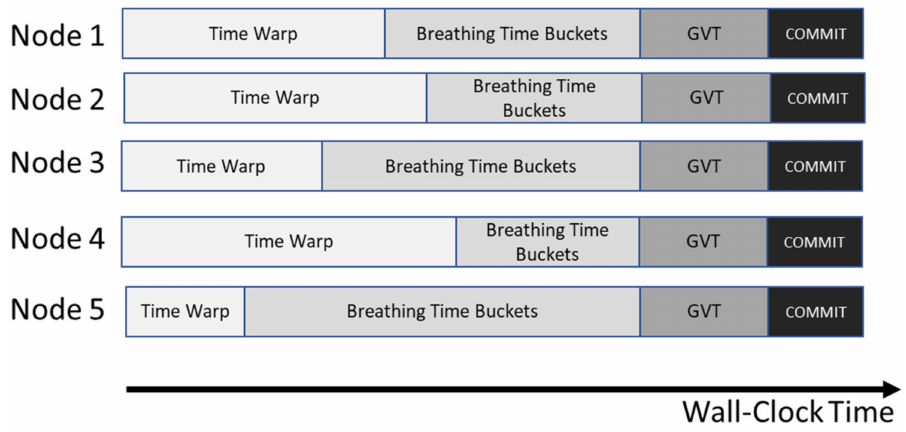
Figure 4. Example of the breathing time warp (BTW) event-processing cycle with a TW phase, a breathing time buckets (BTB) phase, computing of global virtual time (GVT), and the corresponding commitment of events in five